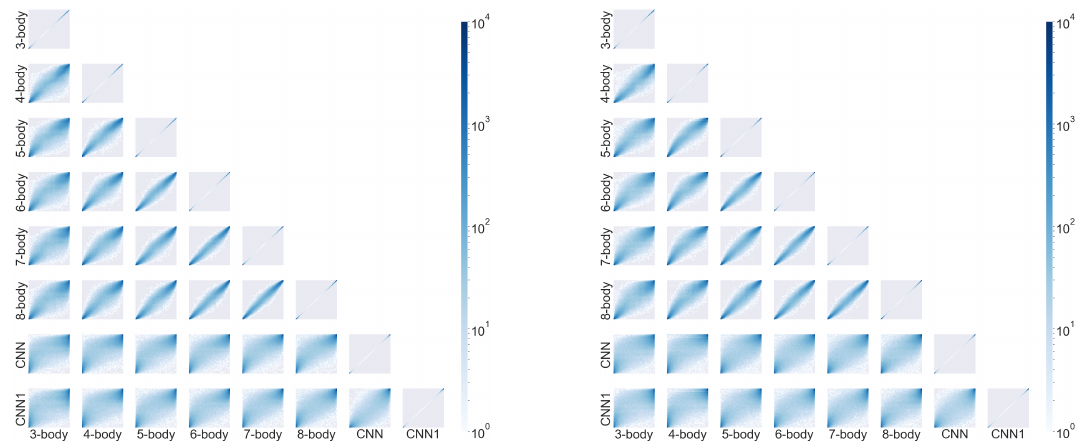
Figure 8: Correlation plots for top quark tagging without mass on the left and with ∈ [ 500,550 ] mass on the right, for p T